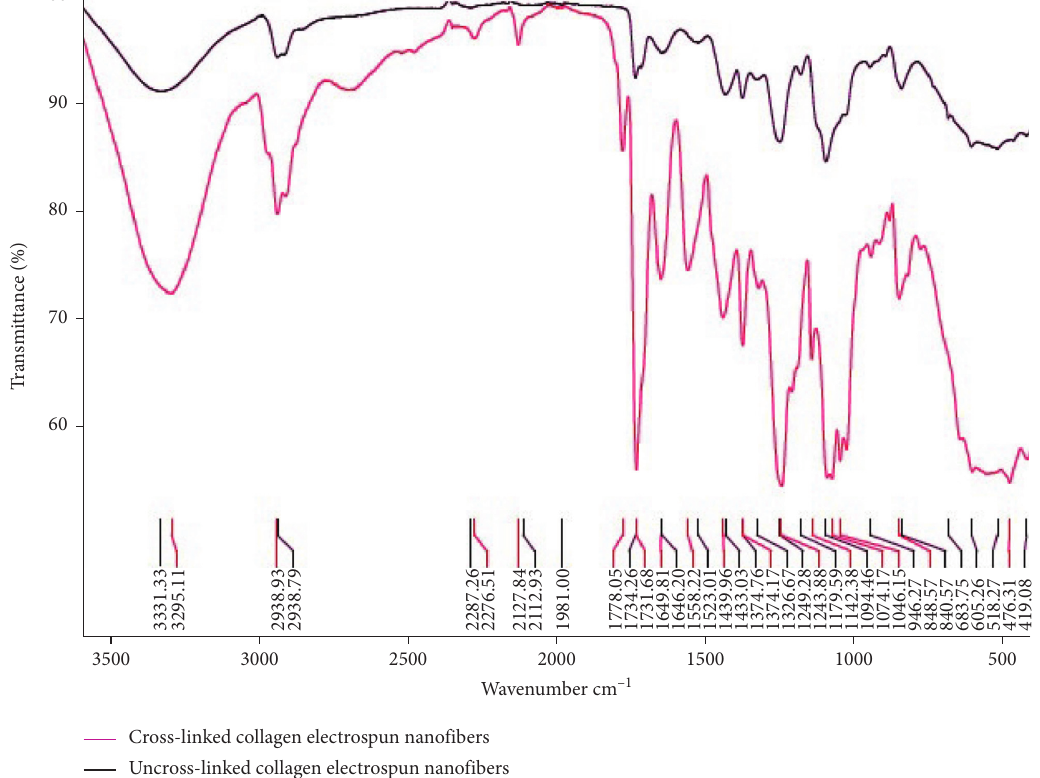
Figure 5: FTIR spectra of uncross-linked and cross-linked collagen electrospun